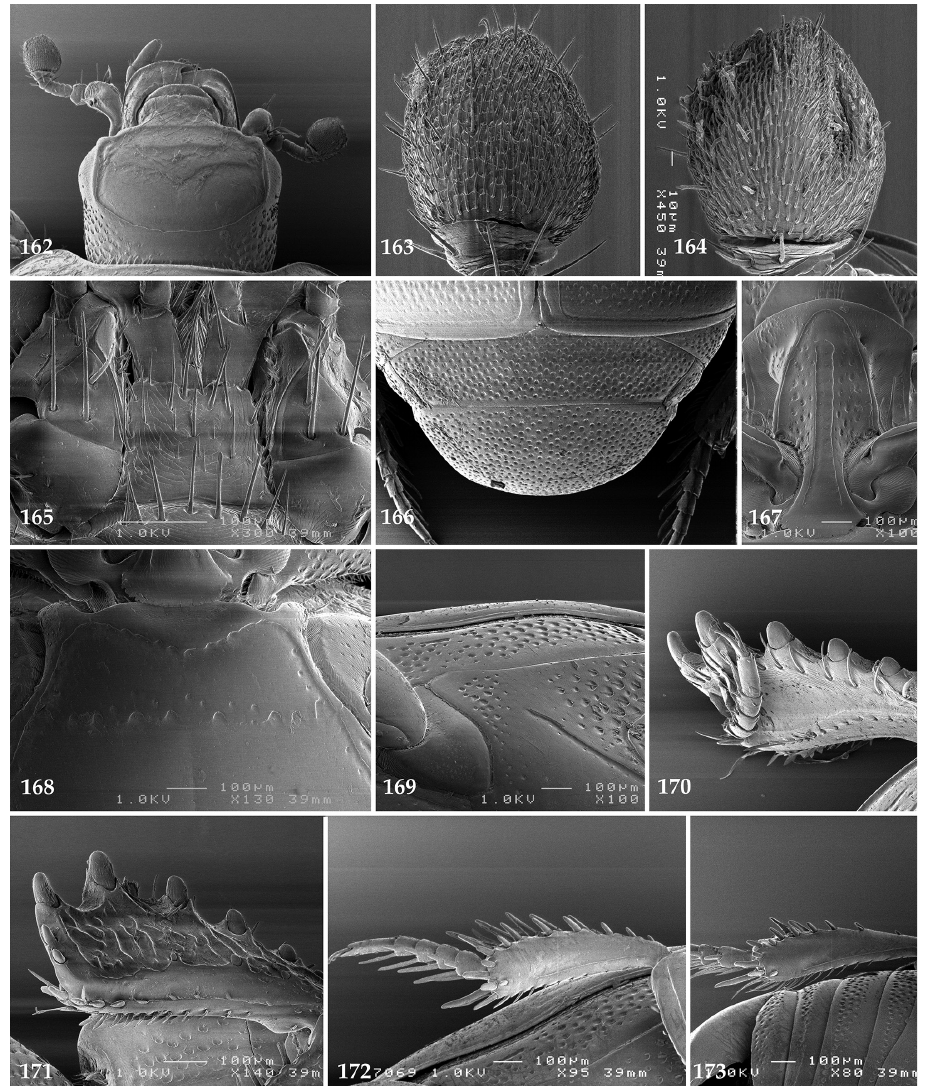
Figures 162–173. 162 Hypocaccus ( Hypocaccus ) sinae (Marseul, 1862) head, dorsal view 163 anten- nal club, dorsal view 164 ditto, ventral view 165 mentum, ventral view 166 propygidium + pygidium 167 prosternum 168 mesoventrite 169 lateral disc of metaventrite + metepisternum 170 protibia, dorsal view 171 ditto, ventral view 172 mesotibia, ventral view 173 metatibia, ventral view.